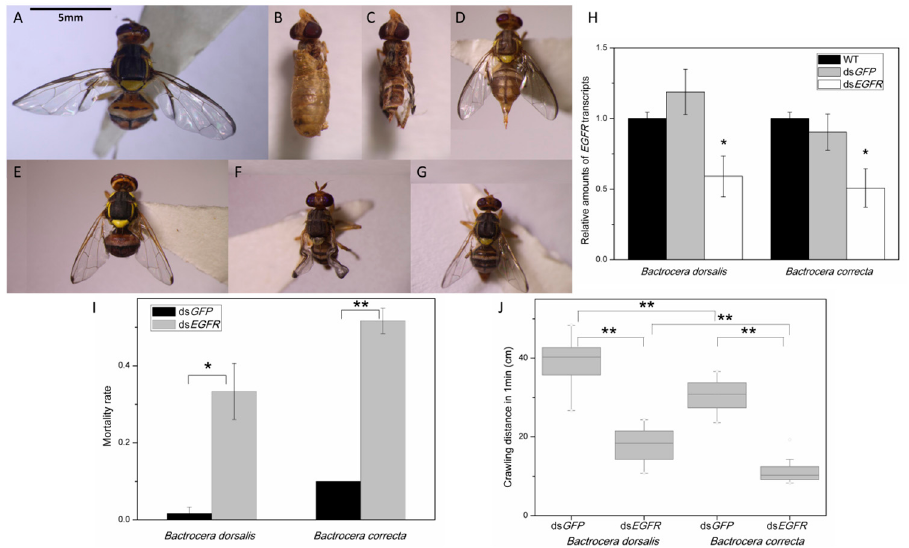
Figure 6. Phenotype analyses and statistics of mortality rates and crawling ability after RNAi. Individuals treated with ds BdGFP ( A ) and ds BcGFP ( E ) do not differ significantly from the wild types; The non-feathering individuals of B. dorsalis ( B ) with fragmentary wings ( C ) in pupae were observed; The deformed phenotypes also included wing-deformed adults ( B. correcta , F ) and the smaller-size adults ( B. dorsalis ( D ) and B. correcta ( G )); The EGFR mRNA levels decreased dramatically in ds EGFR treated groups compared with control groups, and ds GFP treatment did not affect EGFR expression ( H ); (* p < 0.05 according to One-way ANOVA, Tukey’s multi-comparison post-hoc test); Mortality rates of ds EGFR and ds GFP treated groups were calculated ( I ); and the significant variation in crawling ability between ds GFP and ds EGFR treated groups were tested ( J ). (* p < 0.05, ** p < 0.01, according to the Student’s t test).